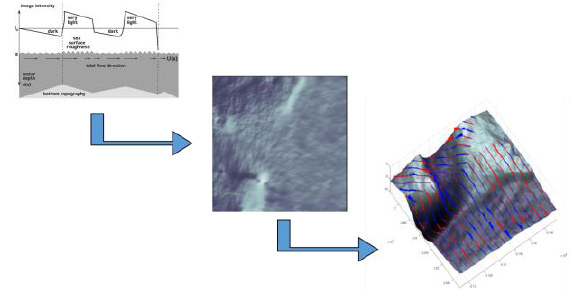
Figure 3. SAR bathymetry process and